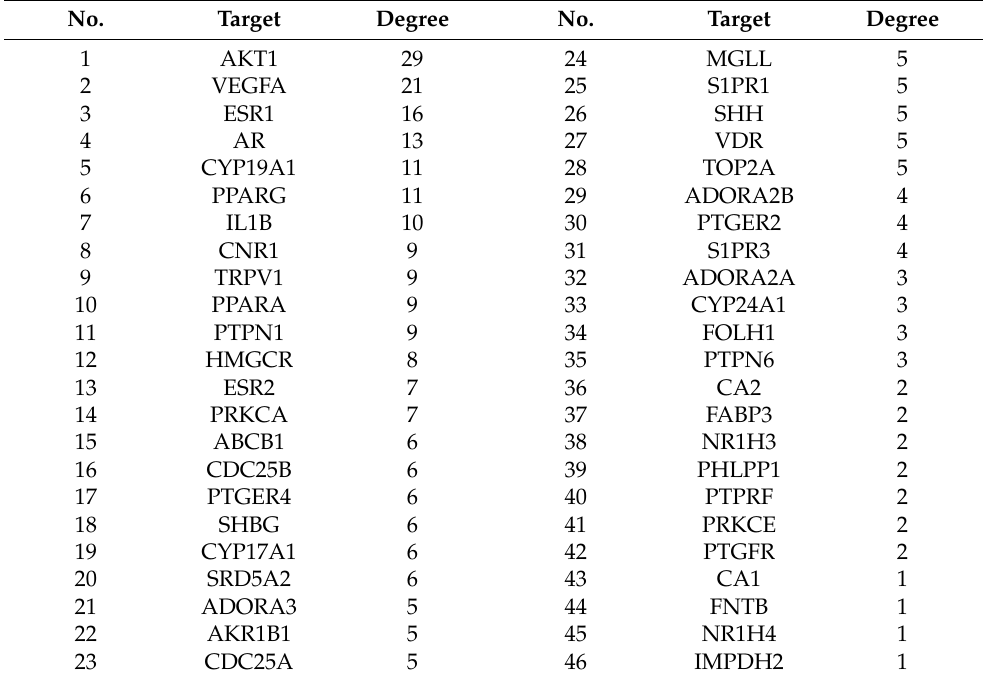
Table 3. The degree value of PPI networks.